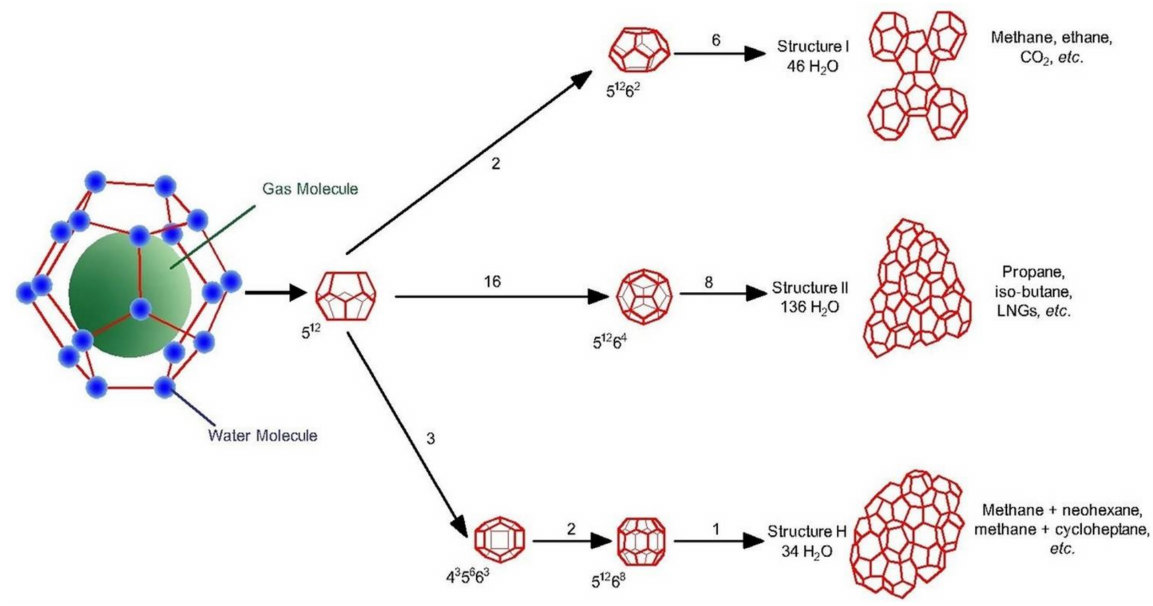
Figure 1. Structure of natural gas hydrate